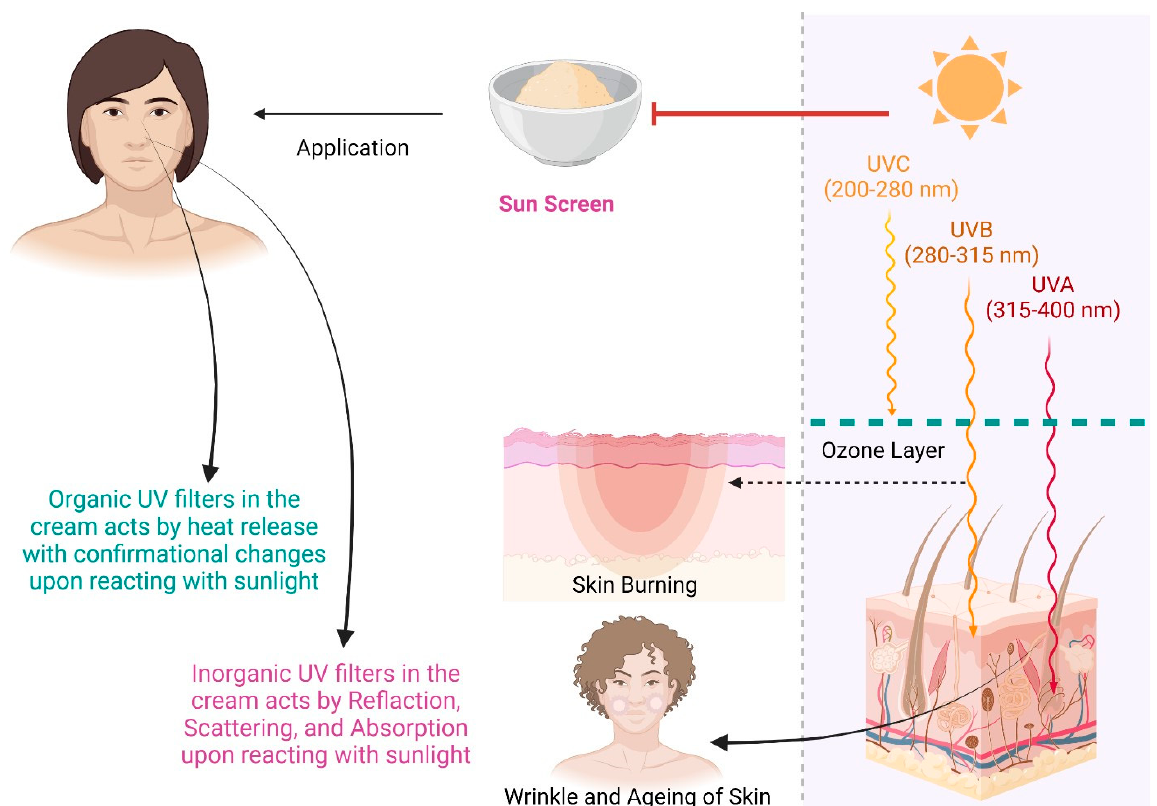
Figure 1. Schematics of the utilization of sunscreens to protect against damaging impacts of sunrays wherein UV rays are responsible for noxious effects attributed to sunlight. Three bands make up the UV region, which has a wavelength range of 100–400 nm: UVA (315–400 nm), UVB (280–315 nm), and UVC (100–280 nm). The ozone layer is currently shielded from UVC rays. High-intensity UVB radiation causes more rapid harm than low-energy UVA radiation, which can penetrate further into the skin and cause long-term impact. Utilizing inorganic UV filters can create a barrier that keeps UV rays from penetrating the skin. This barrier could either reflect or scatter light.